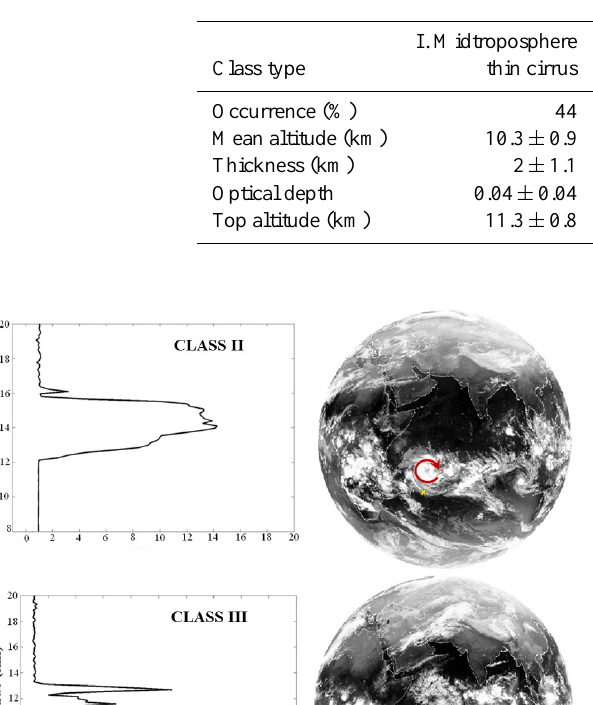
Table 1. Characteristics of the three cirrus classes.